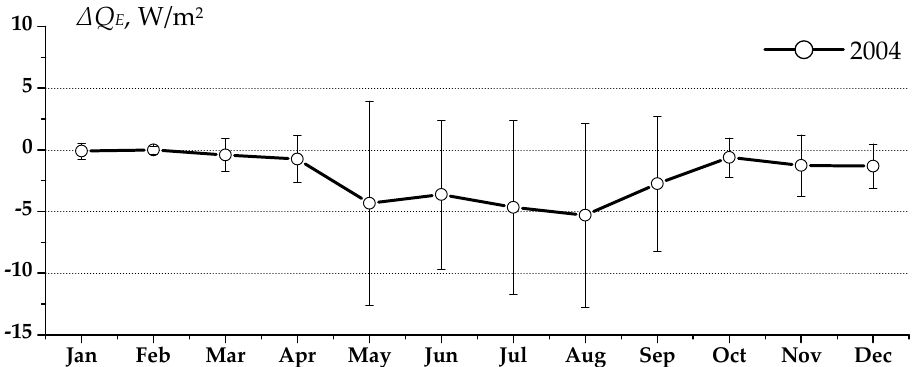
Figure 4. Dynamics of the difference in the heat fluxes associated with evaporation and condensation of water vapor in Tomsk and its background (rural) region.